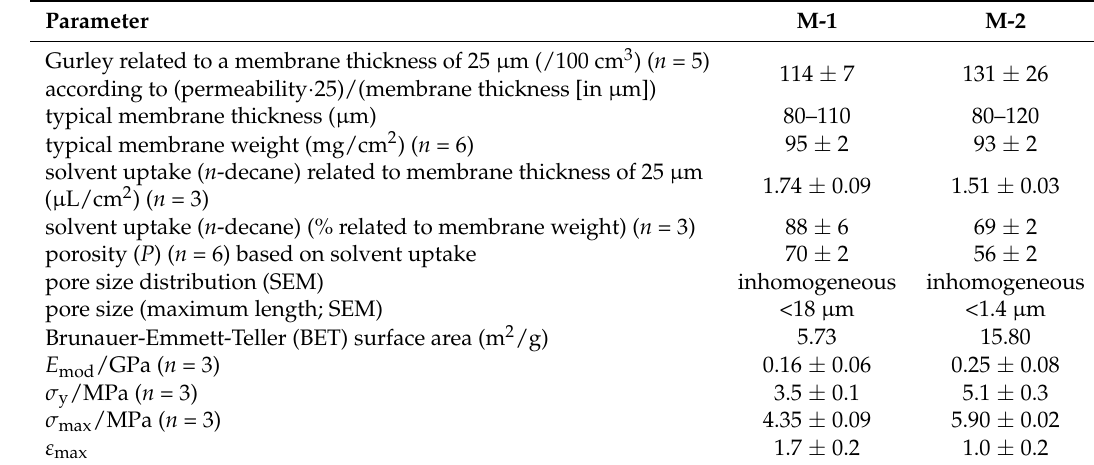
Table 2. Membrane characteristics and mechanical stabilities of both membranes. Provided are the mean value and the standard error (SE) of the mean value from n individual measurements. Parameter M ‐ 1 M ‐ 2